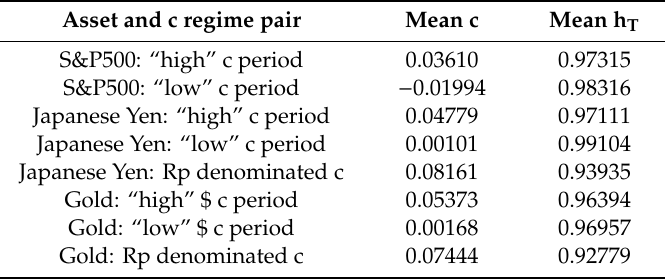
Table A7. Mean c and Mean h T .